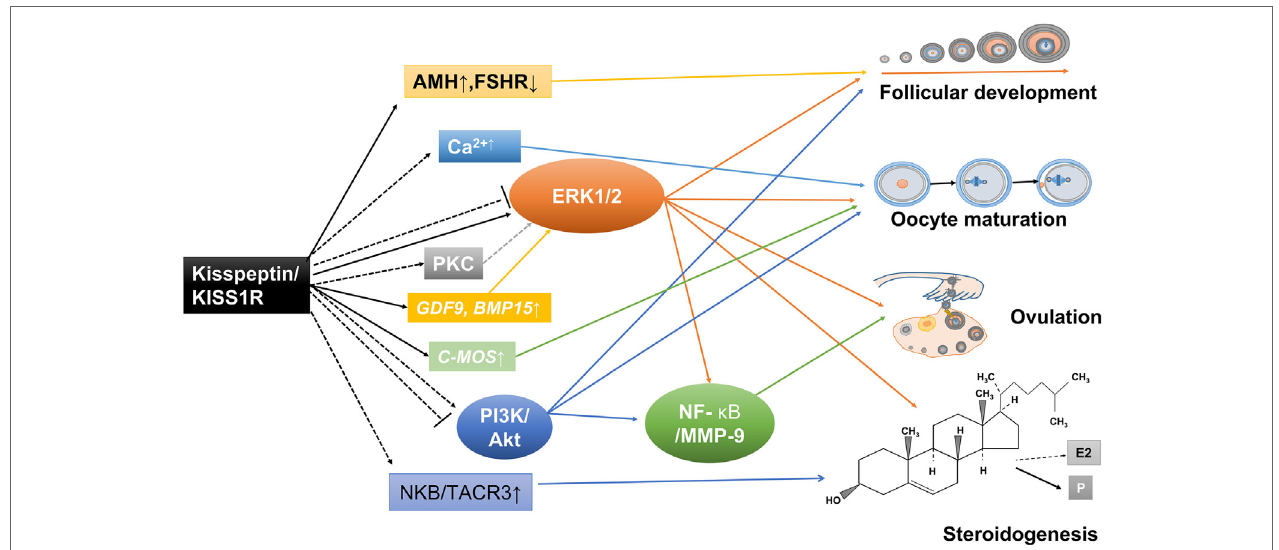
FigURe 3 | Potential mechanisms involved in the direct ovarian effects of the kisspeptin/kisspeptin receptor (KISS1R) system. Kisspeptin and KISS1R are expressed in ovarian cells. This locally produced kisspeptin might regulate follicular development, oocyte maturation, ovulation, and steroidogenesis in a paracrine or autocrine manner. Solid arrows stand for actions that have been clearly demonstrated in ovarian cells. Dotted arrows reflect potential pathways that could be involved in mediating the intraovarian kisspeptin/KISS1R effects, which have been